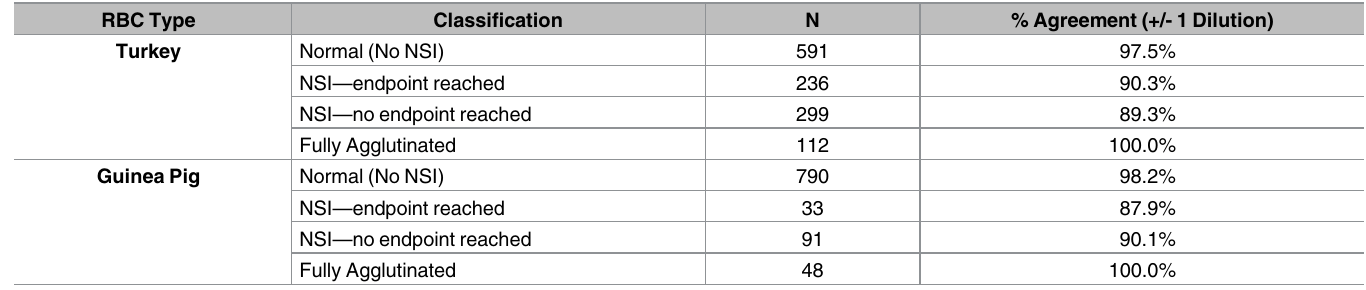
Table 3. Cypher One agreementto expert human readerper sample classification. RBC